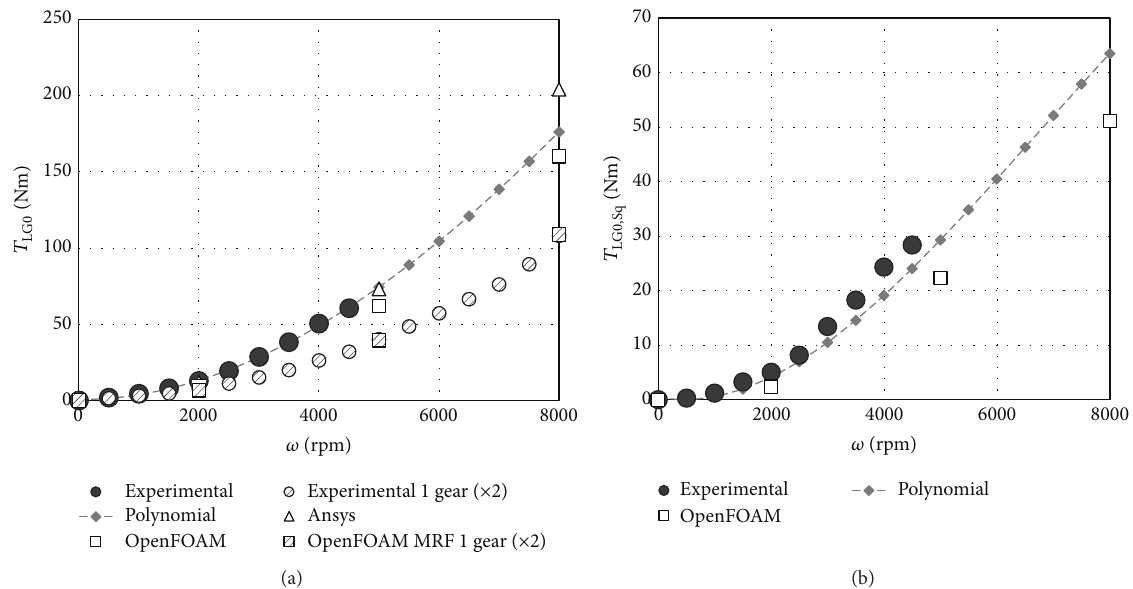
Figure 8: (a) Resistant torque generated by 2 mating gears and by 1 gear ( × 2): experimental and numerical values and (b) squeezing torque evaluated as the difference between the torque generated by 2 engaging gears and a single rotating gear ( × 2): experimental and numerical